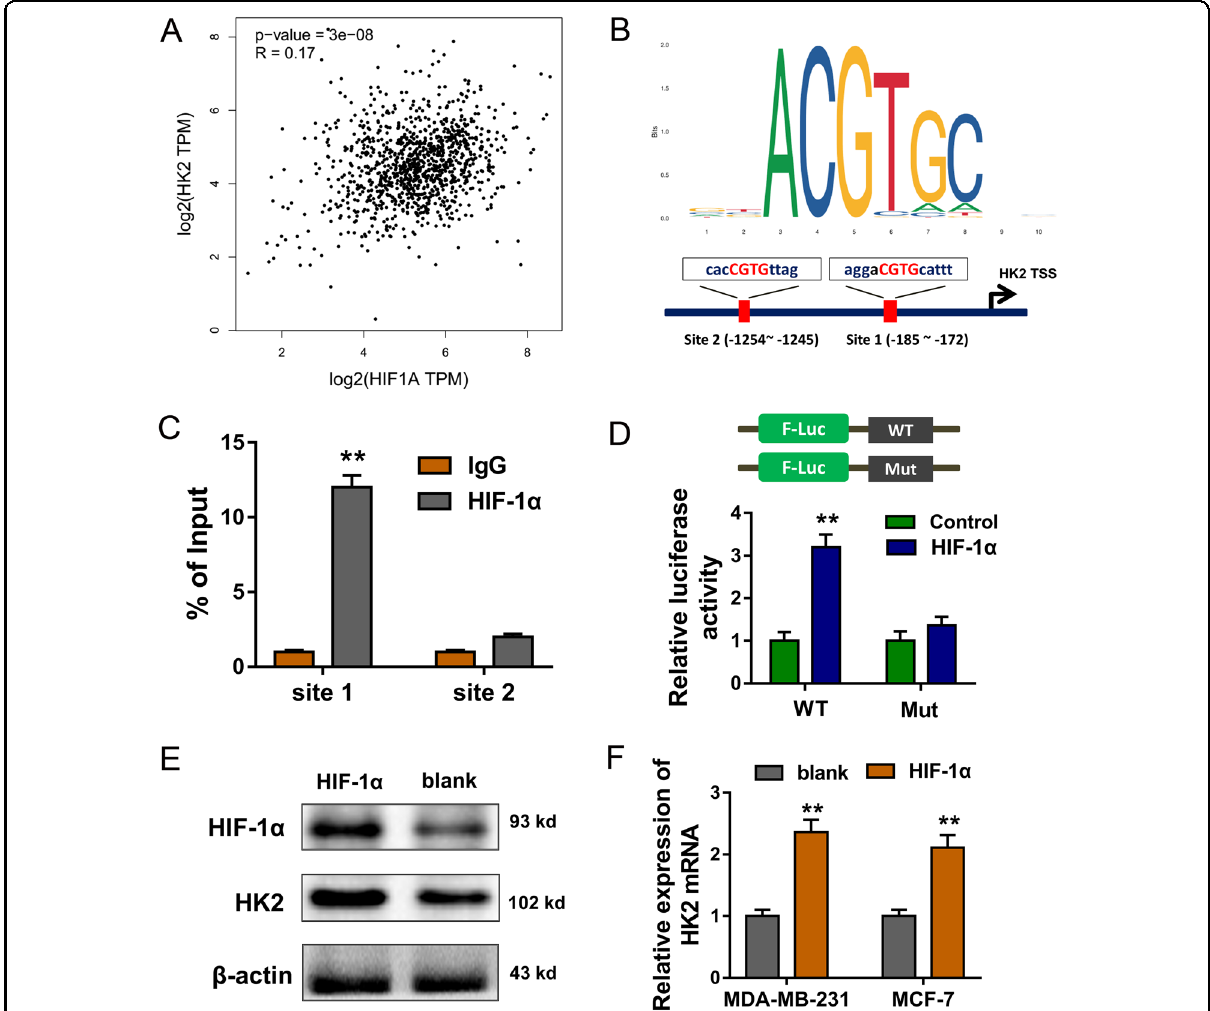
Fig. 5 HIF-1 α facilitates the transcription of HK2. a HIF-1 α was positively correlated with the HK2 expression in BC cohort. b The bioinformatics analysis indicated the putative Hypoxia Response Elements (HRE) (CGTG) on the upstream promoter region of HK2 for HIF-1 α . c Chromatin immunoprecipitation (ChIP) results indicated the binding of HIF-1 α on the site 1 of HK2 promoter. d Luciferase reporter assay indicated the luciferase intensity of HIF-1 α antibody and the wild type or mutant sequence. e Western blot results suggested the HIF-1 α and HK2 protein expression. f RT-PCR indicated the HK2 mRNA in BC cells. ** p < 0.01 vs.